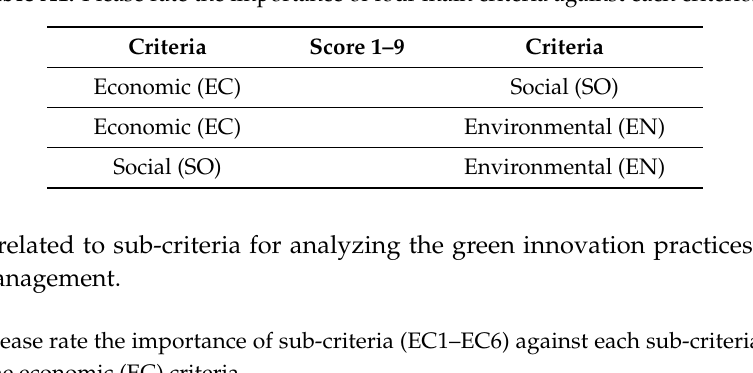
Table A1. Please rate the importance of four main criteria against each criterion.